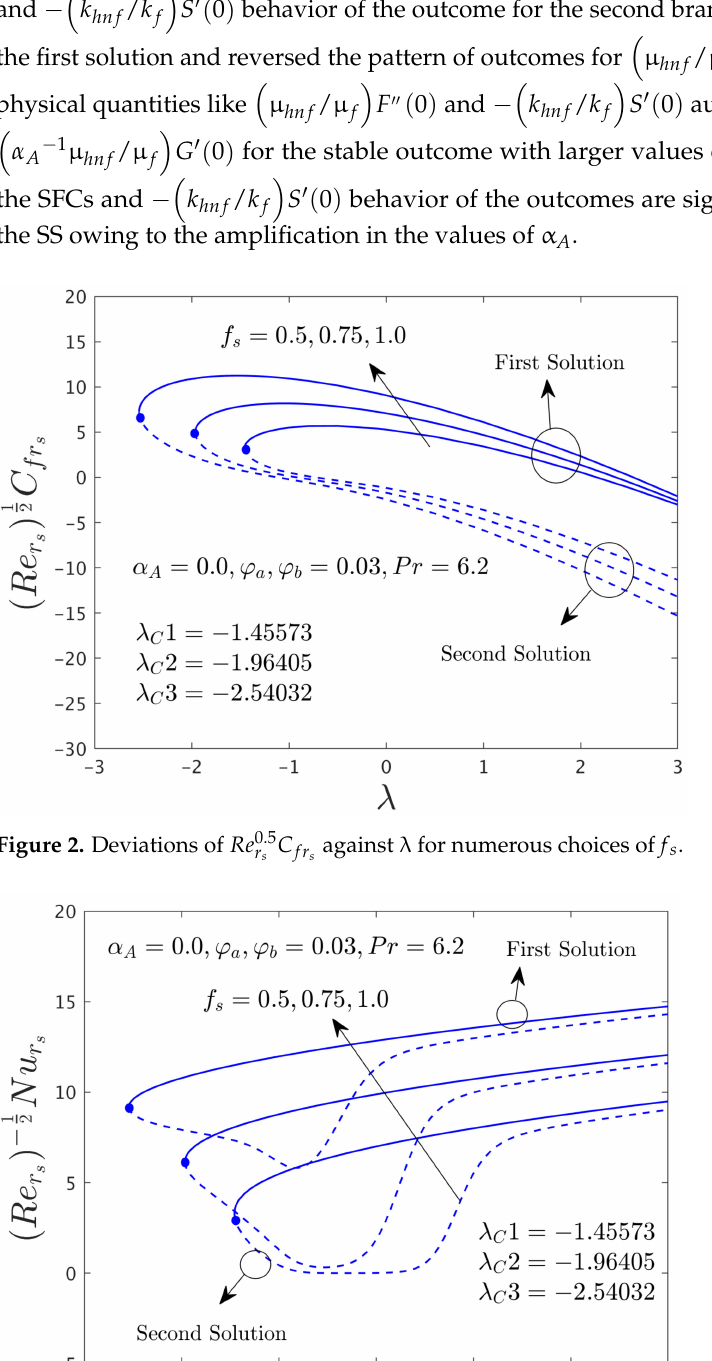
Figure 3. Deviations of Re − 0.5 r